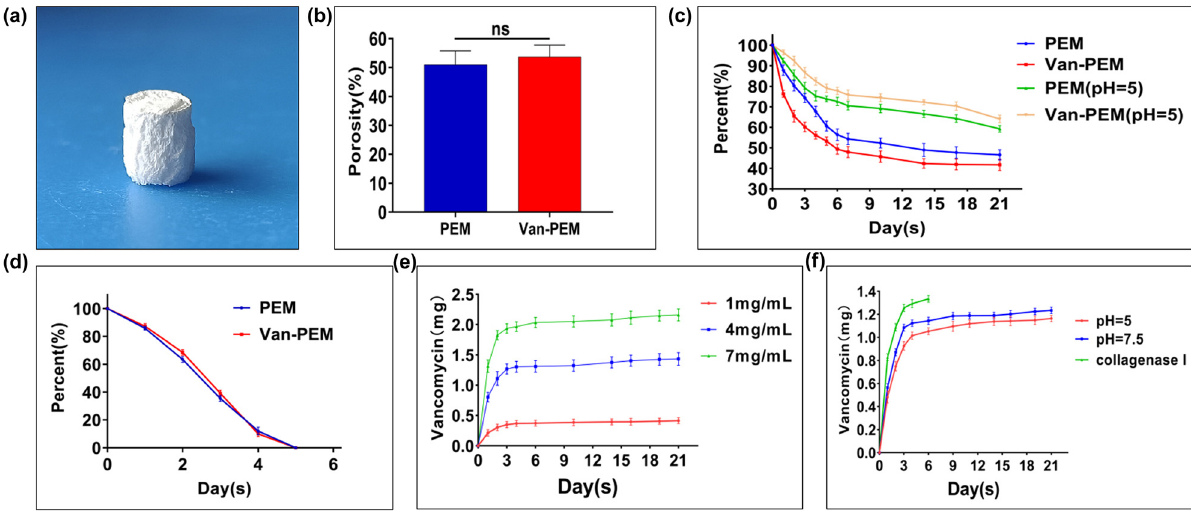
Figure 3: ( a ) Morphology of the Van - PEM hydrogel after lyophilization. ( b ) Porosities of the PEM and Van - PEM hydrogels calculated using the immersion method, proving that the addition of vancomycin did not change the porosity of PEM hydrogel. ( c ) Degradation of the PEM and Van - PEM hydrogels under neutral and acidic conditions exhibited that PEM and Van - PEM hydrogels under neutral and acidic conditions were slowly degraded, and the acidic conditions would not signi fi cantly accelerate the degradation of the hydrogel. ( d ) Degradation of the PEM and Van - PEM hydrogels in the presence of type I collagen protease. ( e ) Vancomycin release from the Van - PEM hydrogel loaded